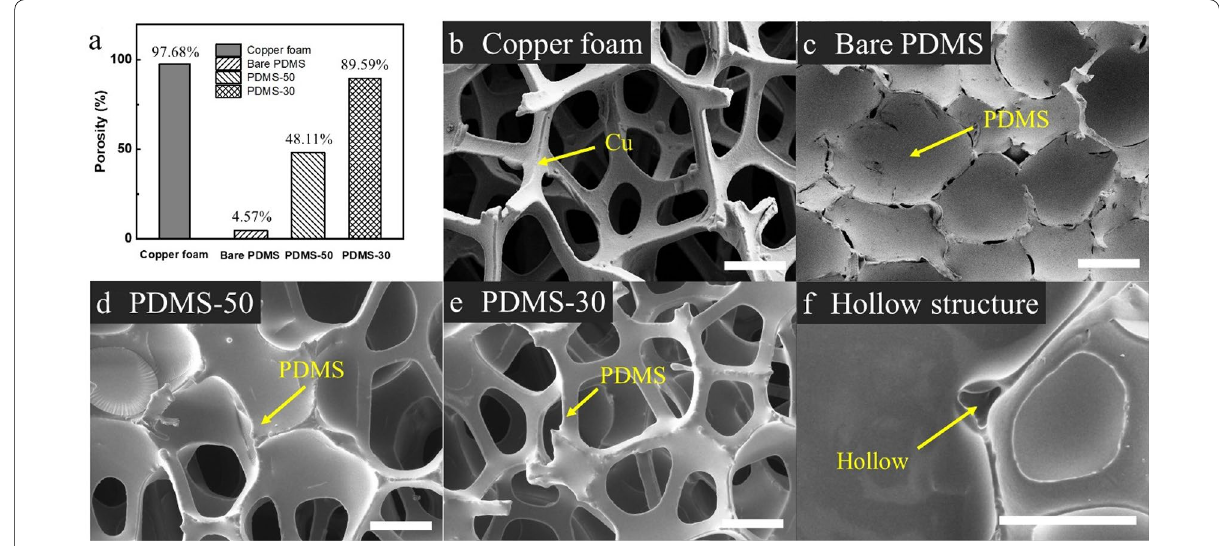
Fig. 2 a Porosity of the copper foam and the fabricated pressure sensors. SEM images are shown of b the copper foam and the pressure sensor based on c bare PDMS, d PDMS-50, e PDMS-30, and f the hollow structure of